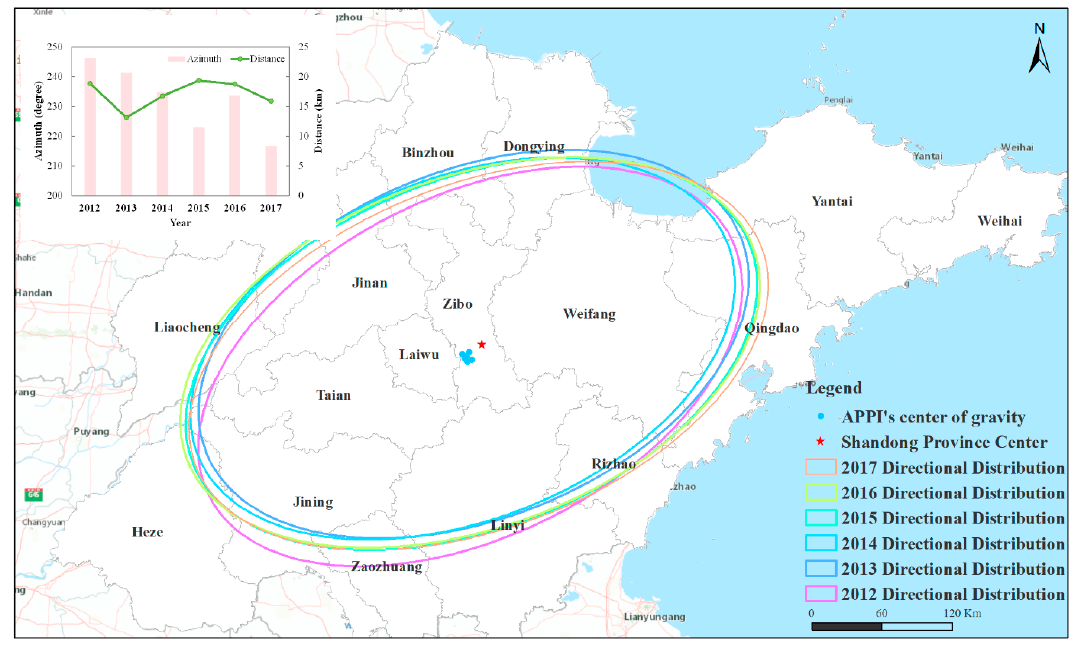
Figure 5. Change of center of gravity of APPI (blue points) from 2012 to 2017. The red five-pointed star in Figure 5 represents the center of Shandong Province, and the blue points represent the center of gravity of APPI in different years. The ellipses in different colors represent the directional distribution of APPI in different years. The green line and pink column in the statistical chart respectively indicate the distance and azimuth angle change between the center of gravity of APPI and the center of Shandong